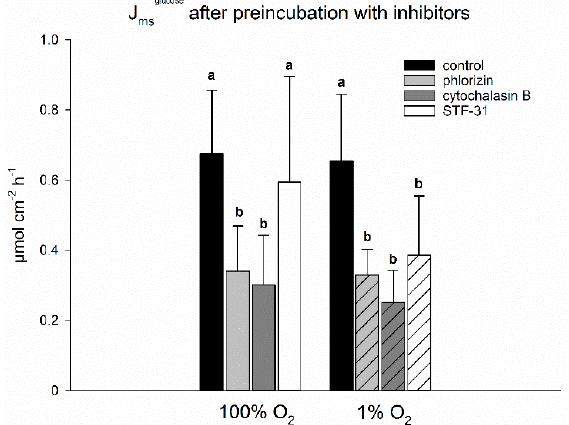
Figure 2. J msglucose across isolated lagomorph jejunum epithelia after the incubation with inhibitors for SGLT1 and glucose transporters GLUT2 and GLUT1. J msglucose was similar under hypoxia and gassing with 100% O 2 . While J msglucose was decreased significantly by phlorizin (inhibiting SGLT1, light grey bars) and cytochalasin B (inhibiting GLUT2, dark grey bars) under both gassing regimes, STF-31 (inhibiting GLUT1, white bars) had an effect under hypoxia (hatched bars) only. Bars represent mean ± SD; one-way repeated measurements ANOVA with a subsequent Holm–Sidak test based on N = 6 ( n = 12), p < 0.05, different letters indicate significantly different flux rates within each group.